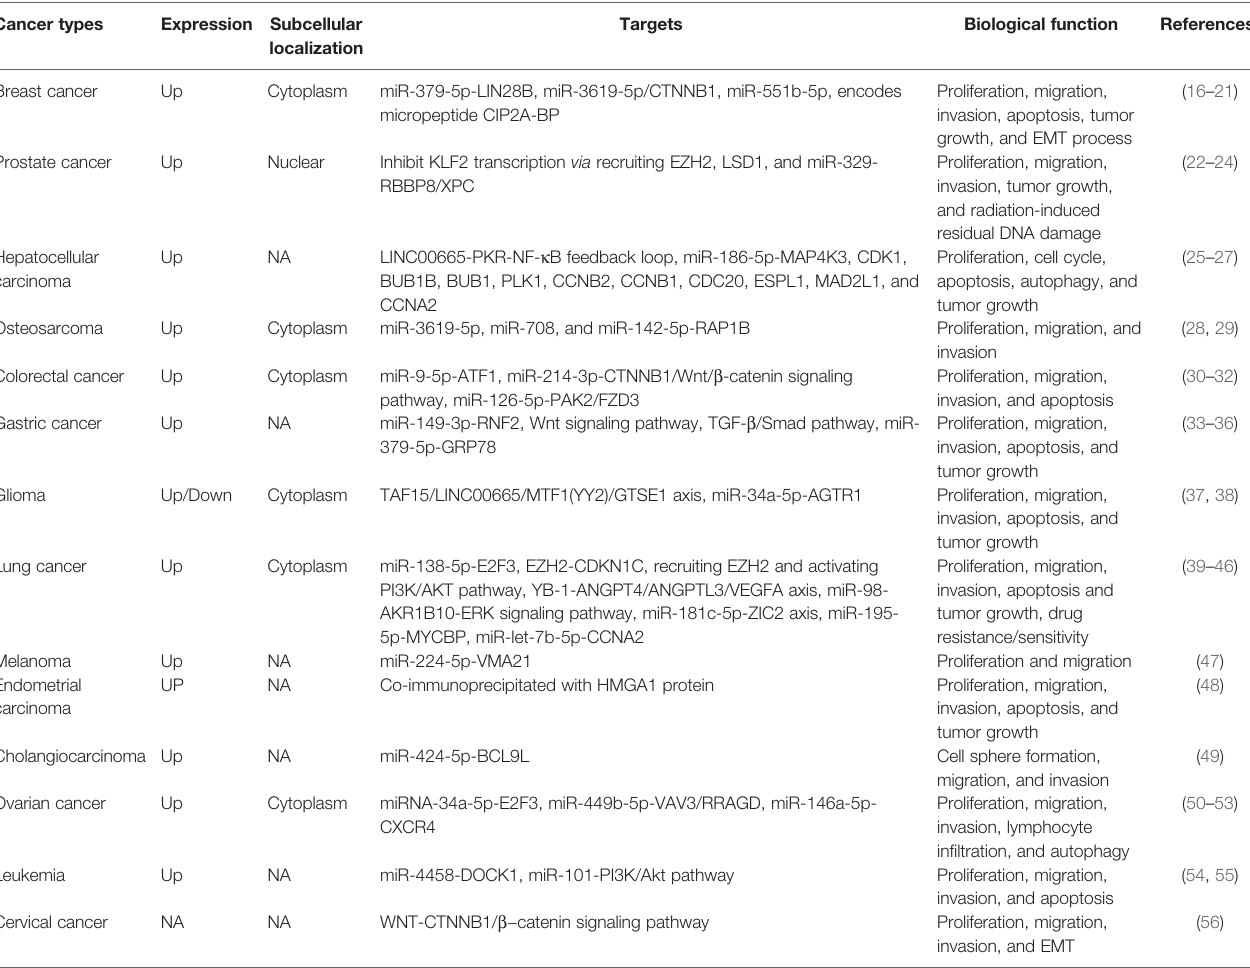
TABLE 1 | Biological characterization of LINC00665 in human